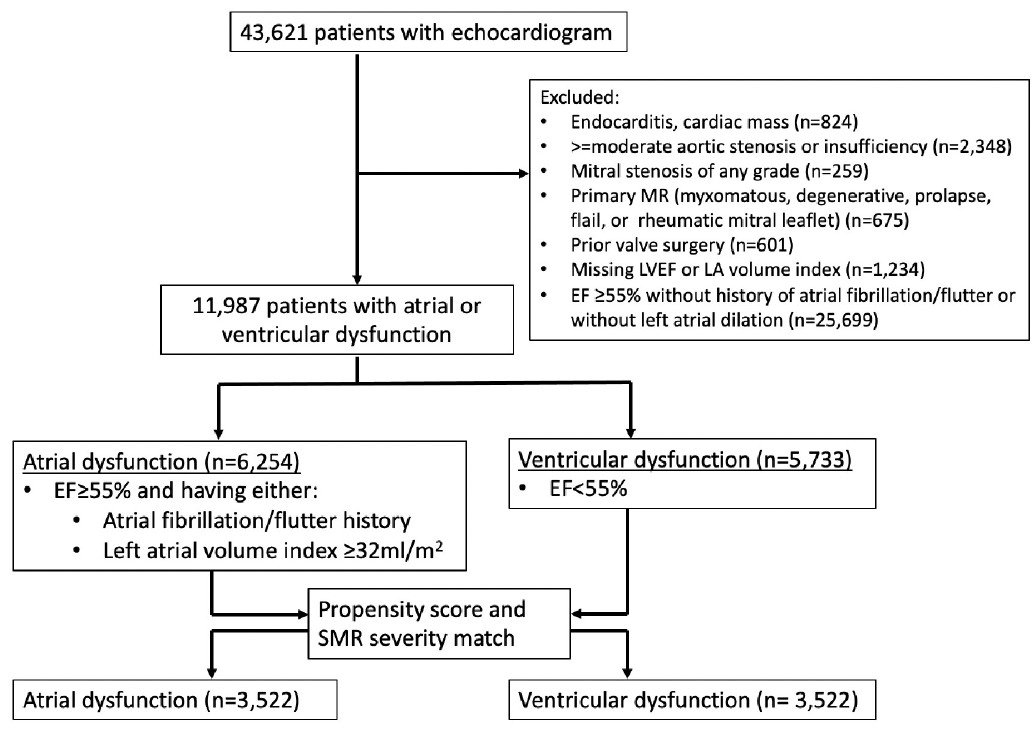
Fig 1. CONSORT-style diagram. The figure shows exclusion criteria and the definition of exposure groups. LA = left atrial; EF = ejection fraction; MR = mitral